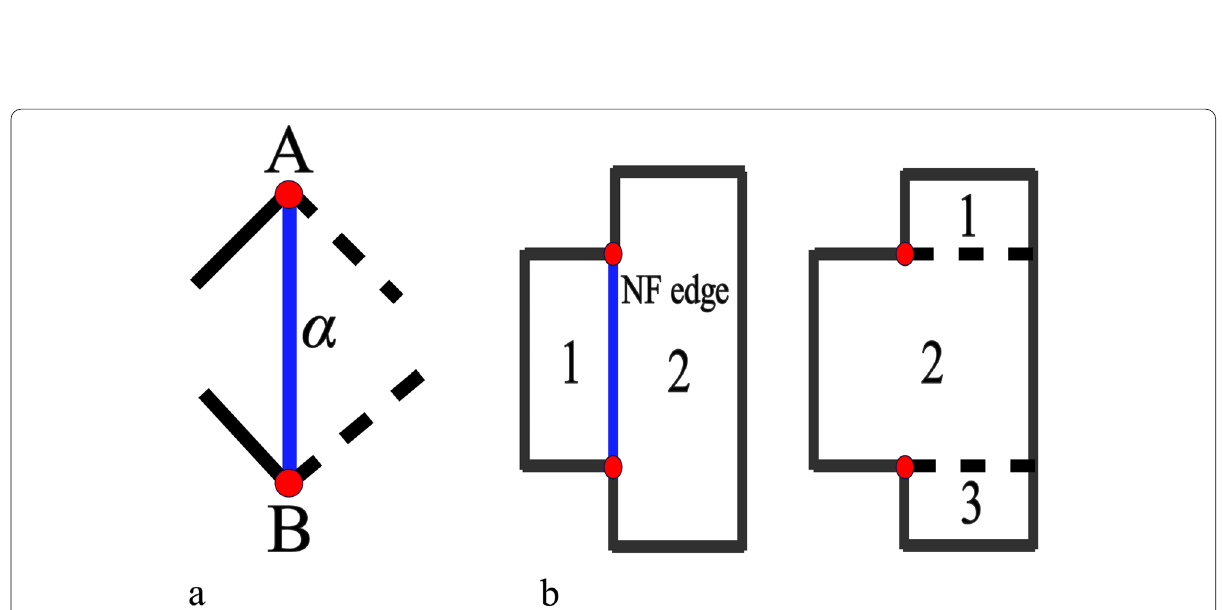
Fig. 10 Information on NF edge. a Definition of NF edges; b Comparison of various